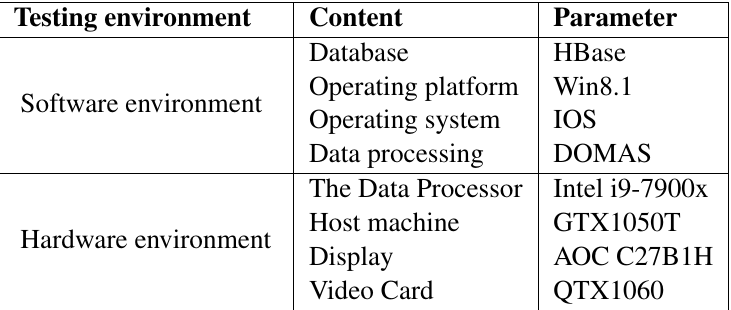
Table 1 Experimental equipment parameters